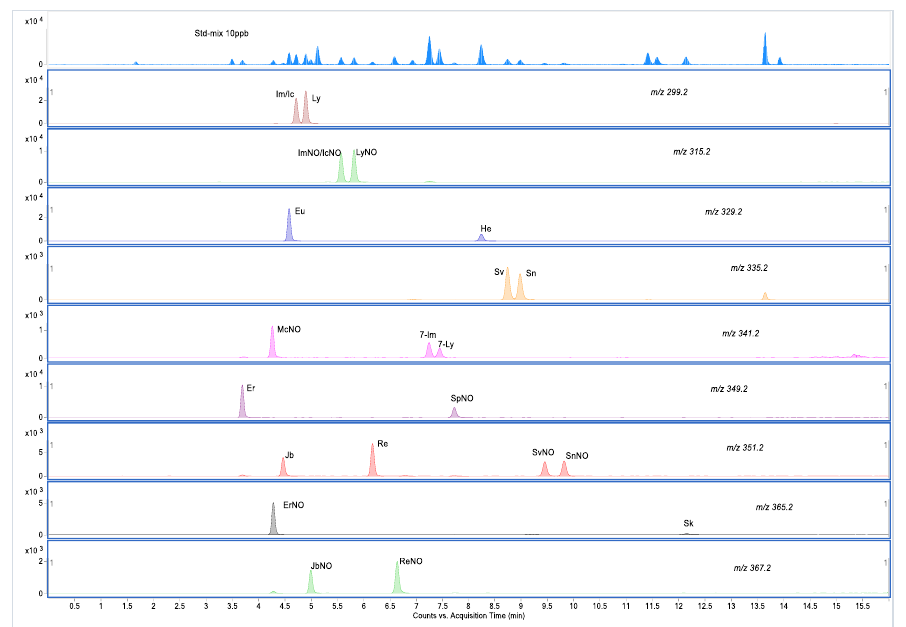
Figure 4. MRM chromatograms of nine sets of isomers with a mixed standard of PAs (10 μg/kg) by LC-MS/MS. For each pair the molecular mass and compound name abbreviations were shown. Only two pairs of stereoisomers (intermedine and indicine, intermedine N-oxides and indicine N-oxides) were not separated, but the two unseparated PAs had the same response value as their